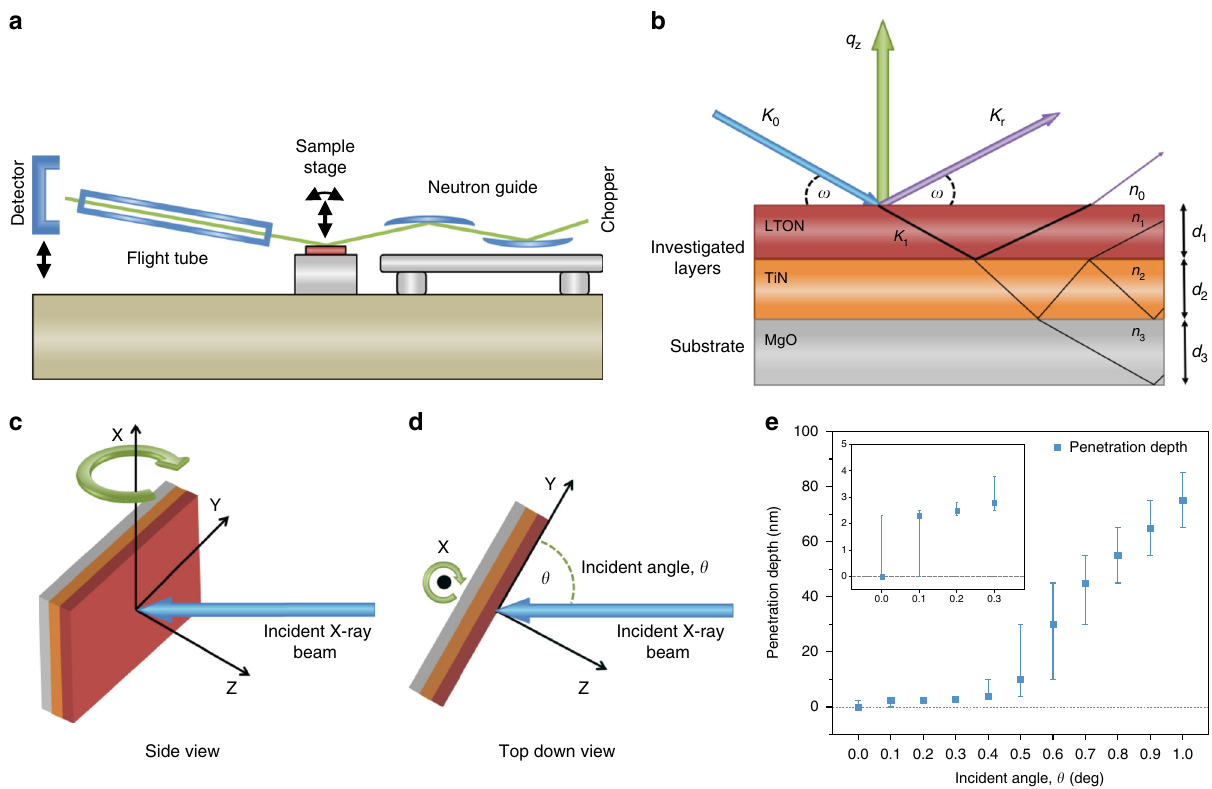
Fig. 2 Experimental overview. a Instrument description for AMOR time-of- fl ight neutron re fl ectometer at SINQ/PSI. b Neutron re fl ectometry measurement for multilayer thin fi lms. c , d Surface-sensitive GIXAS measurement, side view and top down respectively. e Penetration depth of X-rays for LTON at the Ti K edge energy range as a function of incident angle, the error bars correspond to the penetration depth at a given incident angle with an error of ±0.1 degrees. Values taken from ref. 46